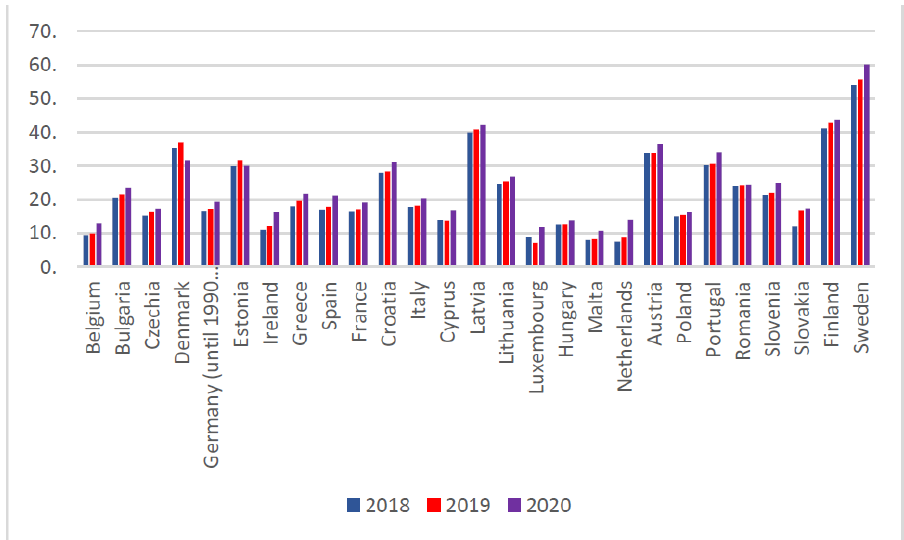
Figure 1. Share of energy from renewable sources in the EU. Source: Own representation based on Eurostat data.